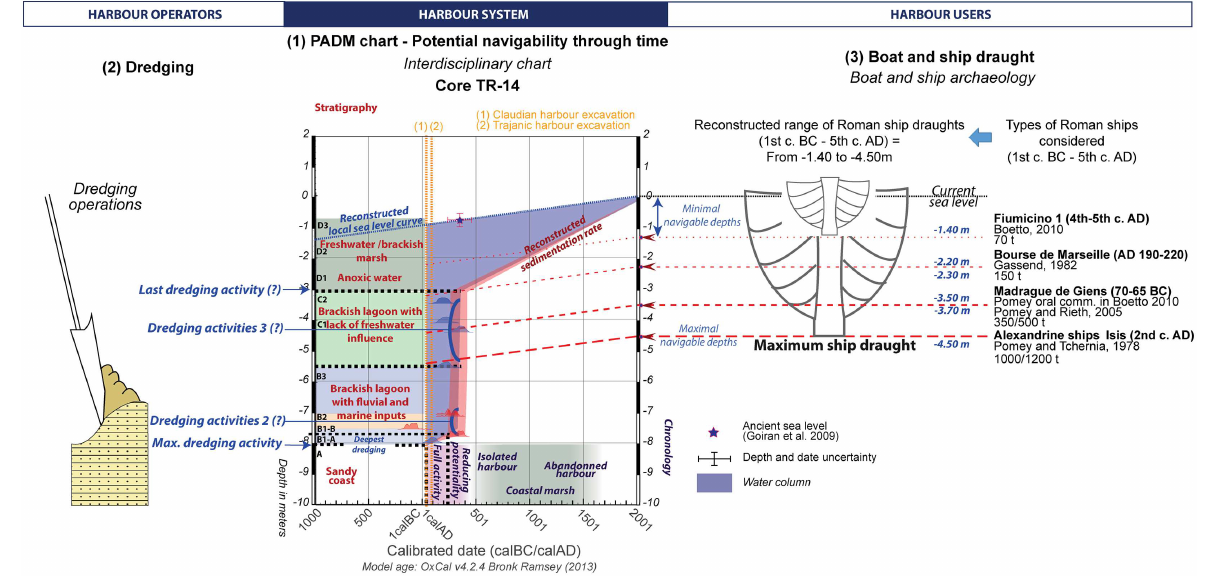
Fig 8. Harbour operation and PADM of the core TR-14. This figure shows the PADM chart of the operatinglife of the pool of the harboursat Portus as reflected in the sedimentary sequenceof core TR-XIV, and expressed by four stratigraphicunits. The PADM chart incorporates stratigraphicdata as well as factoring in the dredginglevel hypothesisand possibleship draughts. Deep dredgingactivities may have occurred in the 3rd -4th c.